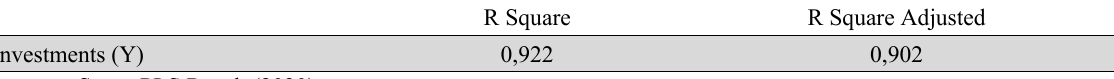
R Square R Square Adjusted